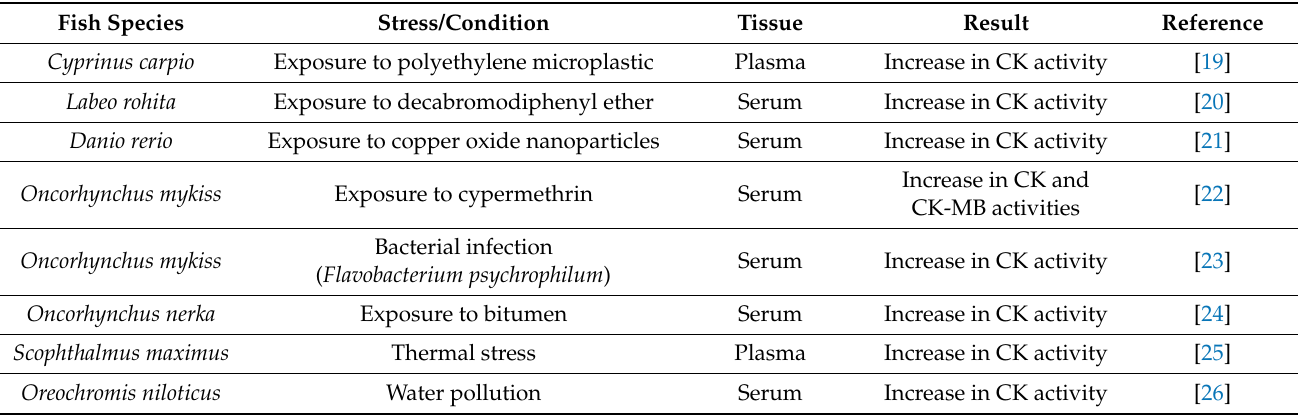
Table 2. The use of serum/plasma creatine kinase (CK) activity as indicator of fish tissue